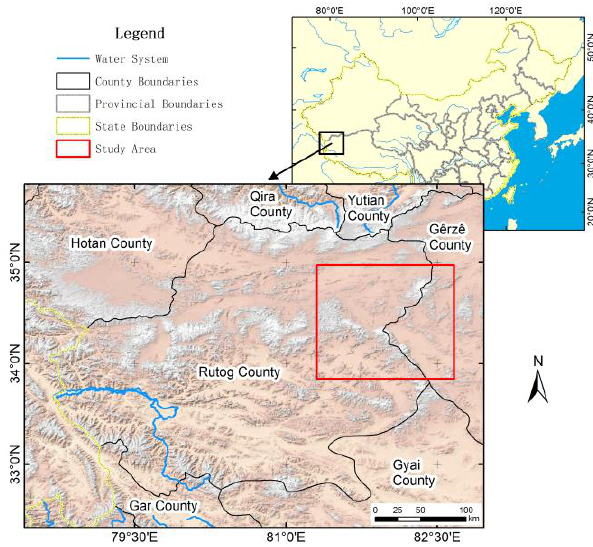
Figure 1. Sketch map of the study area in Rutog county,